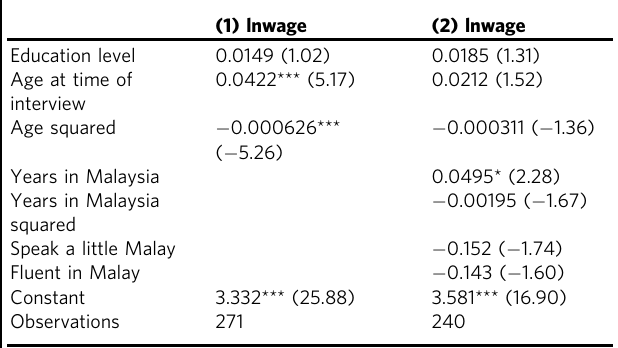
Table 4 Mincer earnings regressions for daily